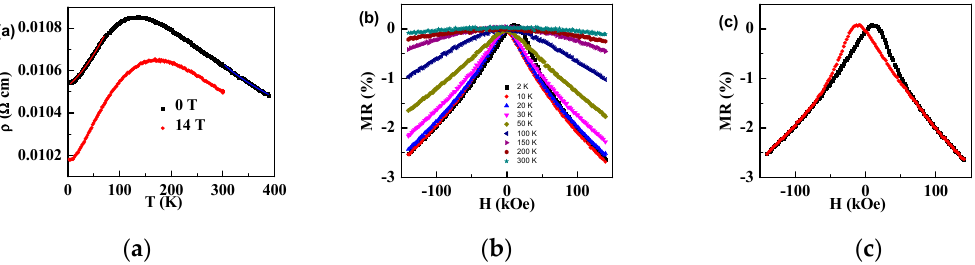
Figure 4. ( a ) The resistance versus the temperature of Ir 0.9 Mn 1.05 Sn 1.05 , at 0 T and 14 T, with the red line as the fitting line with the metallic transport ρ = ρ 0 + BT 2 ; ( b ) magnetoresistance (MR) versus the applied magnetic field of Ir 0.9 Mn 1.05 Sn 1.05 at 2 K, 10 K, 20 K, 30 K, 50 K, 100 K, 150 K, 200 K, and 300 K; and ( c ) MR of Ir 0.9 Mn 1.05 Sn 1.05 at 2 K with the hysteretic butterfly shape.